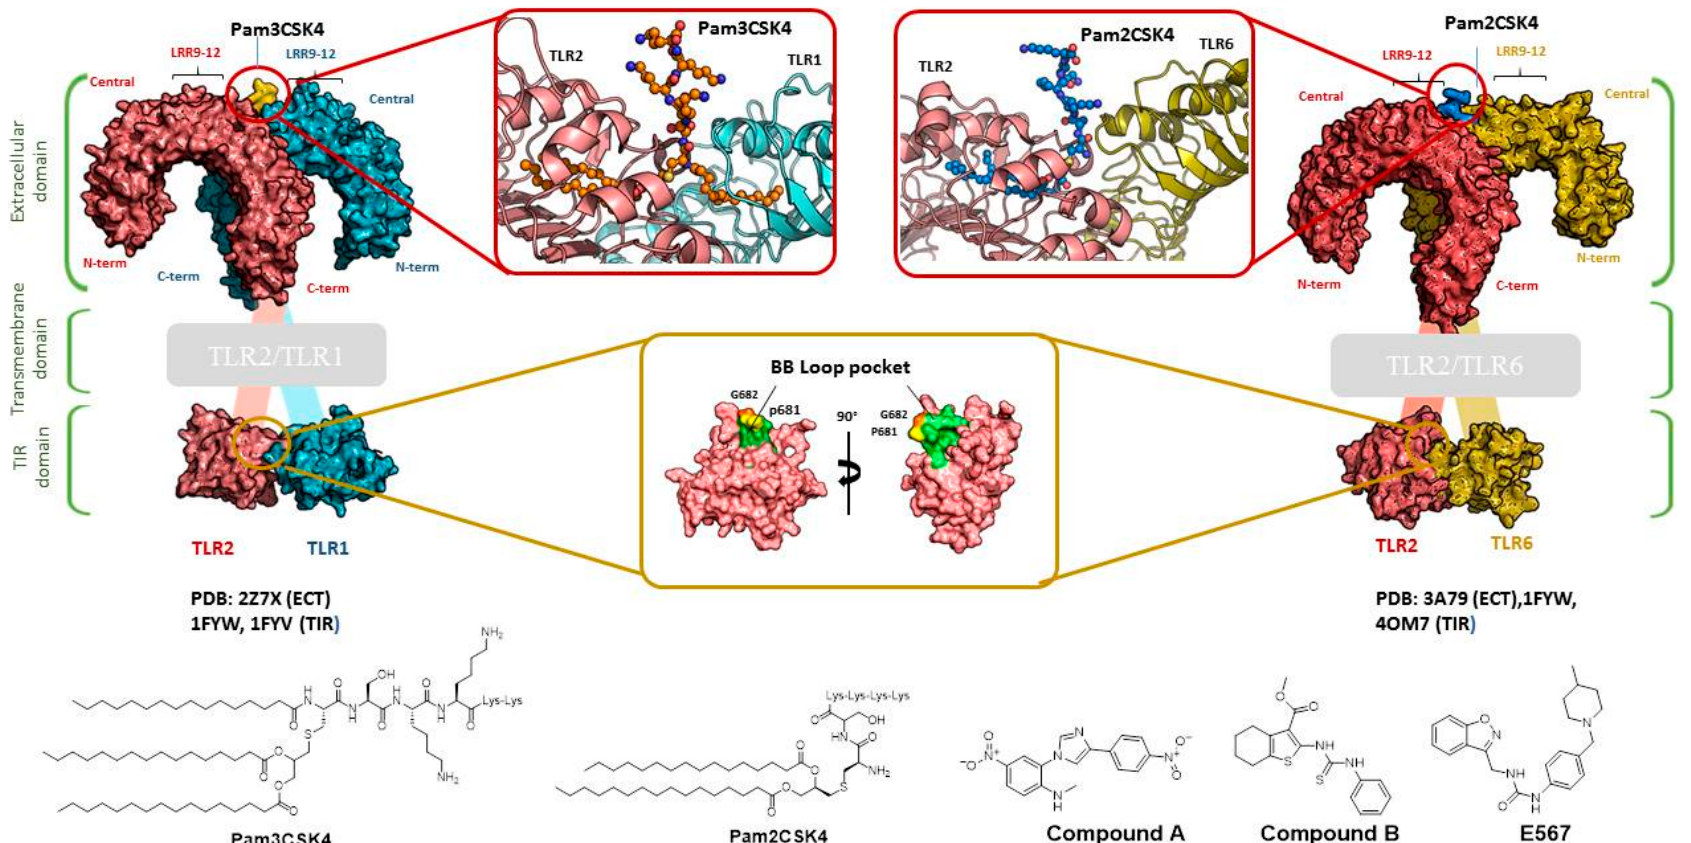
Figure 2. Representations of the 3D structures of TLR2/1 ( left ); and TLR2/6 ( right ) complexes with Pam3CSK4 and Pam2CSK4, respectively. The 2D structure of some compounds mentioned in the text are shown.